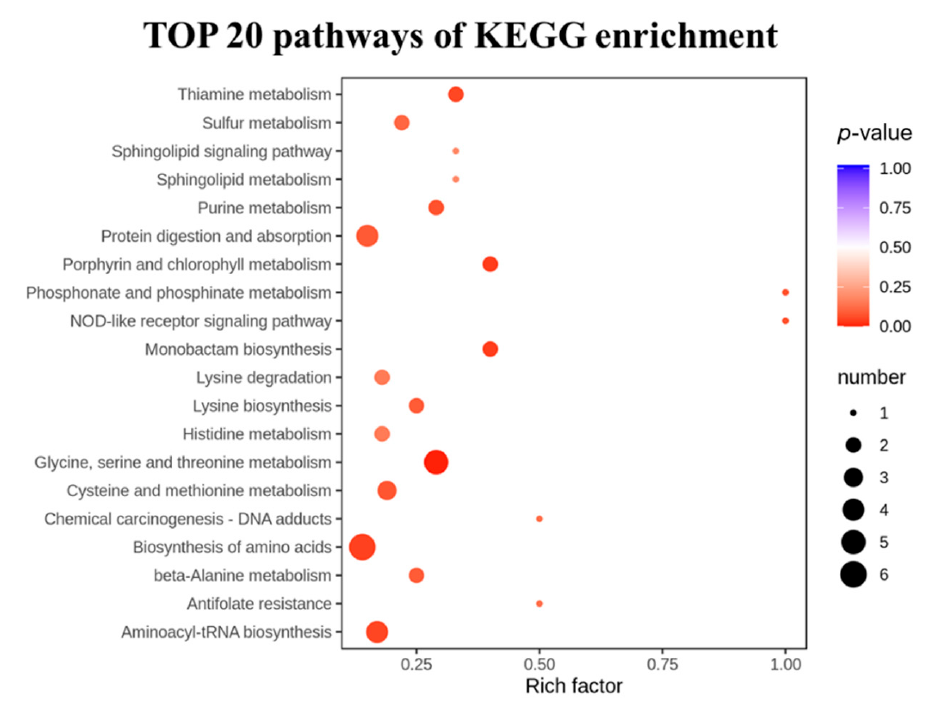
Figure 4. The TOP 20 significantly enriched pathways.